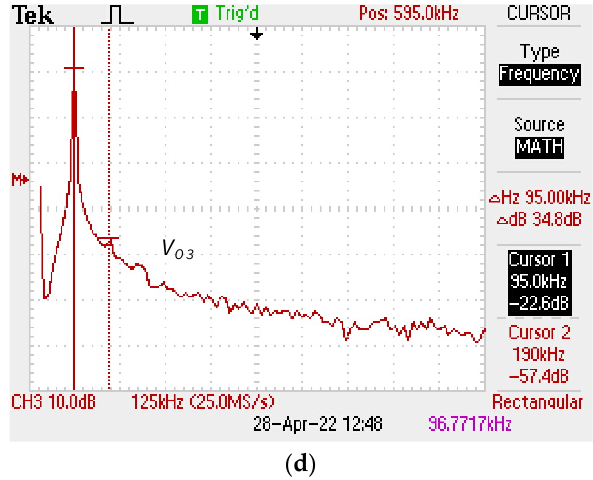
Figure 10. Experimental voltage output waveforms: ( a ) three-phase sinusoidal signals; ( b ) spectrum V O1 ; ( c ) spectrum of V O2 ; ( d ) spectrum of V O3 .